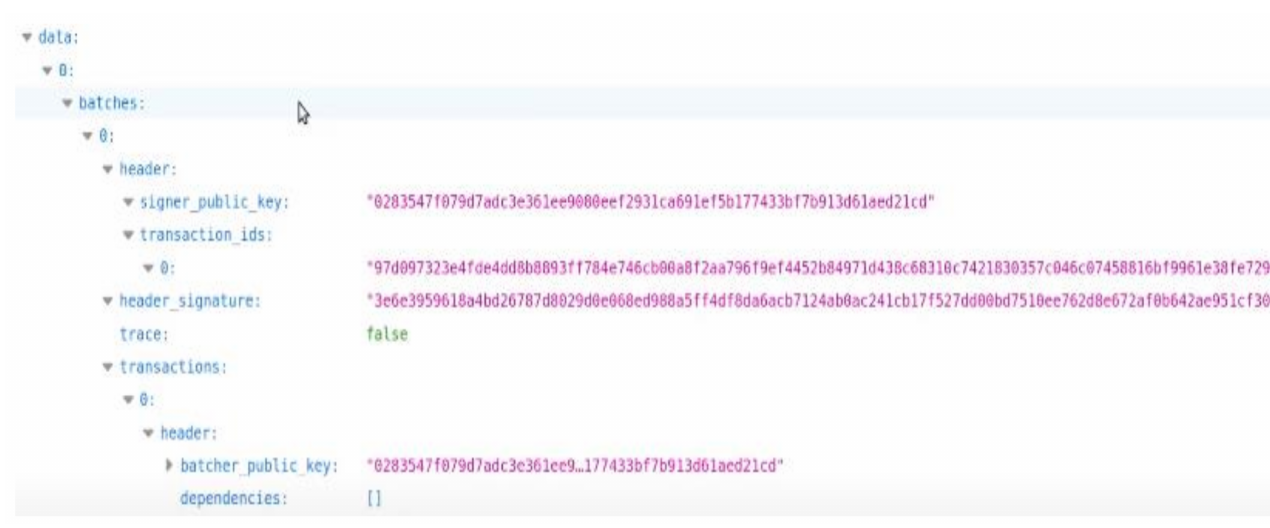
Figure 8. Web-based blockchain Sawtooth-enabled renewable energy and power chain of node interface.